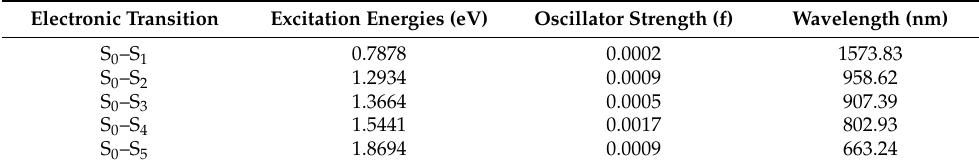
Table 2. Excited states parameters of PbS/Er-3MR local structural model (a).